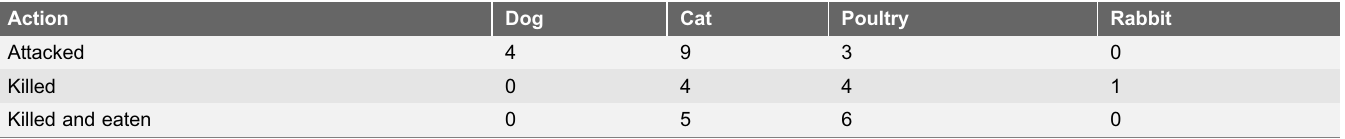
Table 2. Red fox attacks on domestic animals in urban areas in